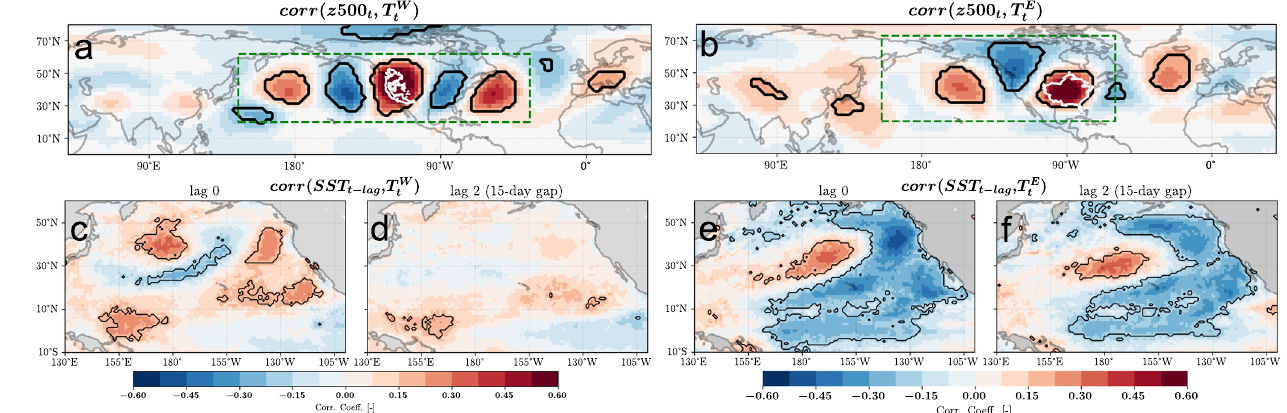
Fig. 1 Correlation maps for different variables against western ( T W ) and eastern ( T E ) US temperature variability. Correlation map between geopotential height at 500 hPa (z500) and T W (panel a ) and T E (panel b ). Panel ( c ), ( d ), ( e ) and ( f ) are similar to the upper panels, but versus SSTA, showing instantaneous and lag 2 correlation values. Based on 15-day mean data. For the signi fi cance ( α FDR = 0.05), we correct for the False Discovery Rate using the Benjamini/Hochberg correction. Gridcells are highlighted by black contour lines if they are signi fi cant at least 60 out of 70 data subsets ( “ Method ” ). The white contour line indicates the western US cluster (panel a ) and eastern US cluster (panel b ). The green rectangles in ( a ) and ( b ) indicates the region that is used to calculate the spatial covariance, see “ Method ”